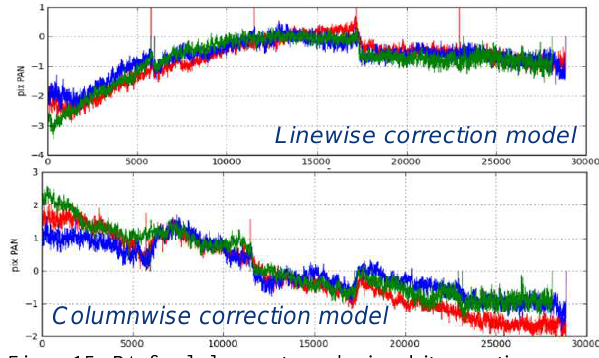
Figure 15 : PA focal plane cartography in-orbit corrections Concerning, the XS bands, the relative cartography is processed thanks to correlation with the PA band and between XS bands good PAN-Sharpening.